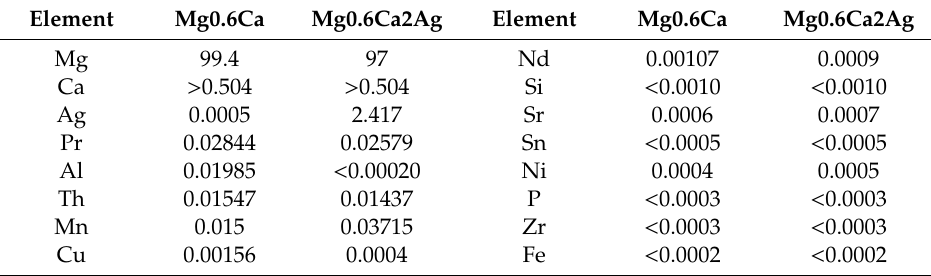
Table 1. Spark OES analysis of Mg0.6Ca and Mg0.6Ca2Ag alloy composition